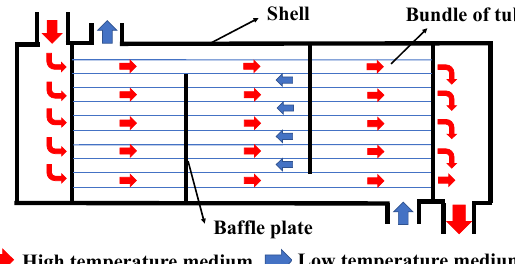
Figure 3. Structural schematic of shell-and-tube heat exchanger [33]. Reproduced with permission from Li et al., Energy Conversion and Management; published by Elsevier, 2019.